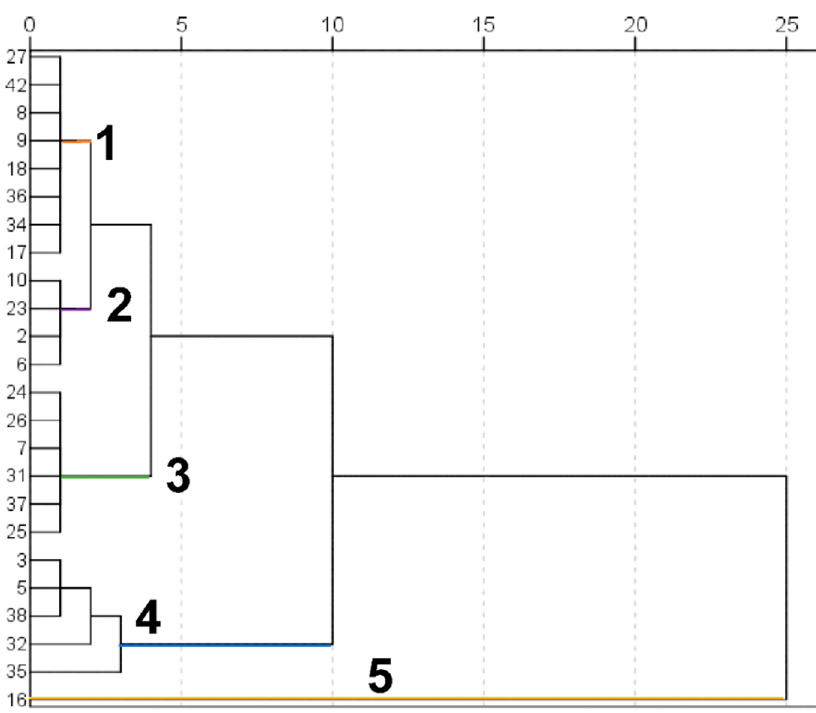
Figure 6. Dendrogram obtained from the cluster analysis.